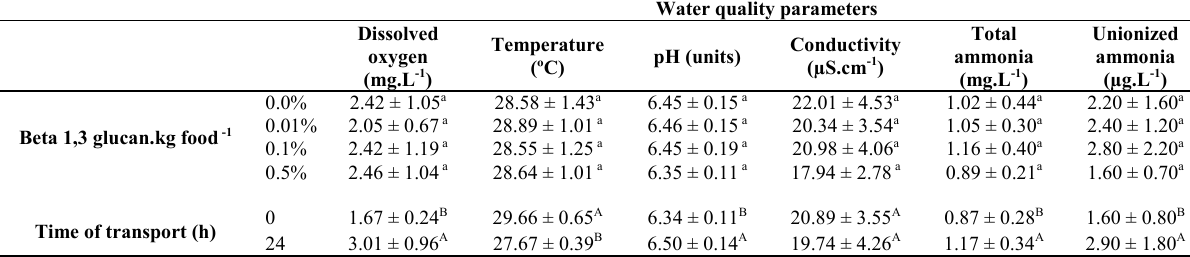
Table 2. Water quality parameters before and after 24 hours of transportation of pencilfish ( N. trifasciatus ) previously fed with different levels of beta 1,3 glucan. Mean ± standard deviation. Same small letters indicate no differences among treatments (means of all sampling times are represented with the same value) and capital letters among samplings times (means of all treatments are represented with the same